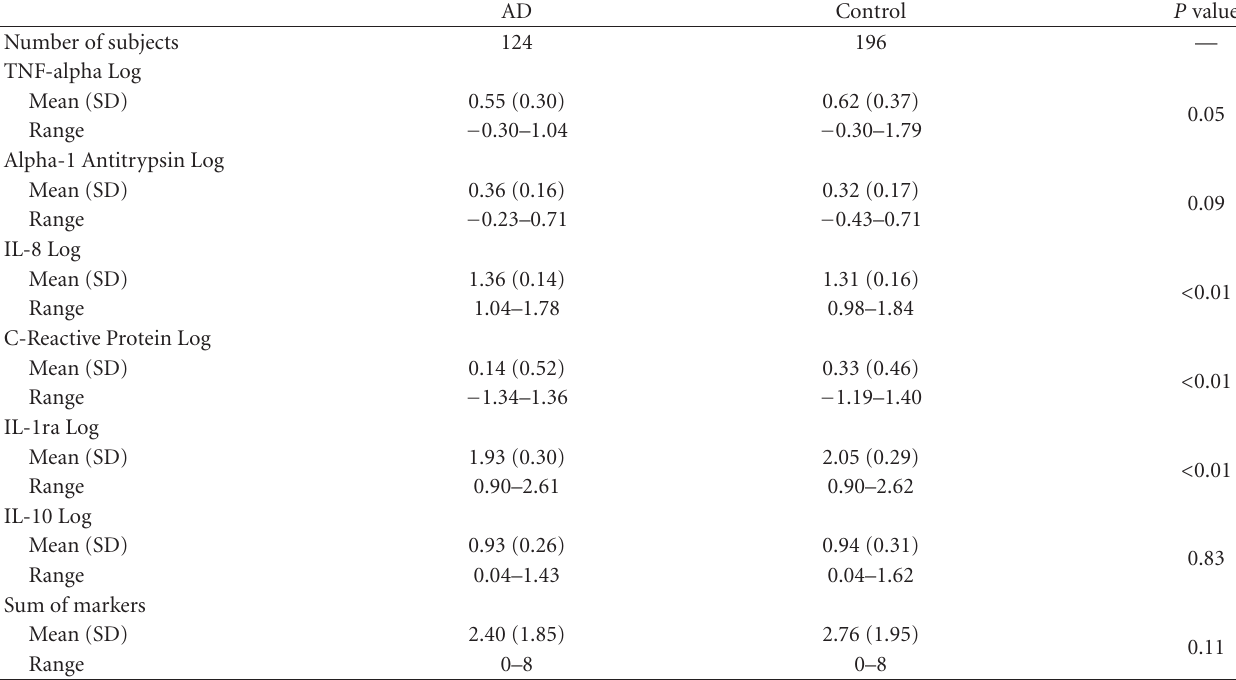
Table 4: Biomarkers by